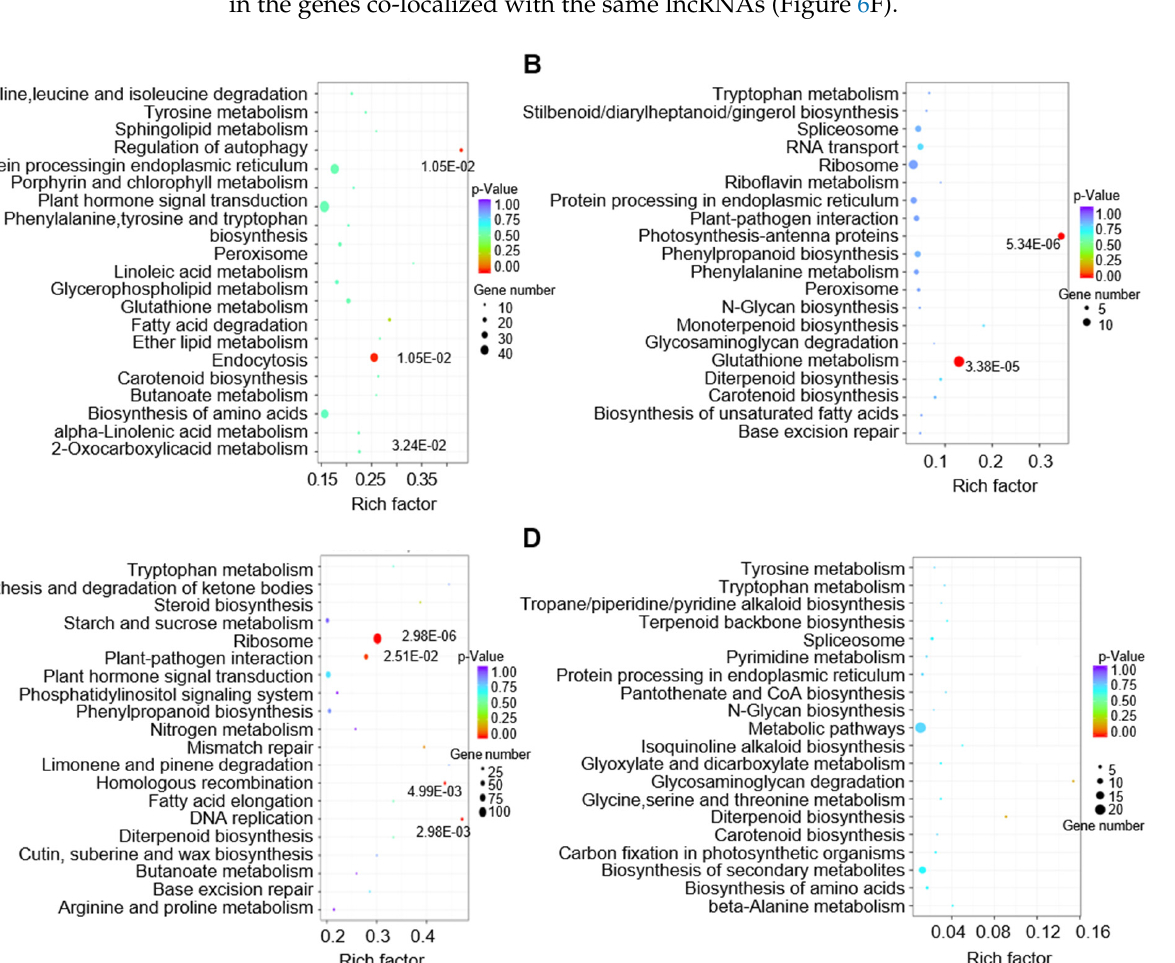
Figure 6. Biological function analysis of genes co-expressed and co-localized with classified lncRNAs. ( A, B ) KEGG anal- ysis of genes co-expressed (A) and co-localized (B) with lncRNAs whose expression levels consistently increased in fruits from 5dpa to 40dpa, related to Figure 5A. ( C, D ) KEGG analysis of genes co-expressed (C) and co-localized (D) with lncRNAs whose expression levels consistently decreased in fruits from 5dpa to 40dpa, related to Figure 5B. ( E, F ) KEGG analysis of genes co-expressed (E) and co-localized (F) with lncRNAs isolated in Figure 5C. GPl, glycosylphosphatidylin- ositol. The p-value of significantly enriched pathway was marked accordingly. 4. Discussion It has been known that lncRNAs play essential roles in diverse biological processes in plants. In tomatoes, thousands of lncRNAs have been identified in flower and fruit tis-